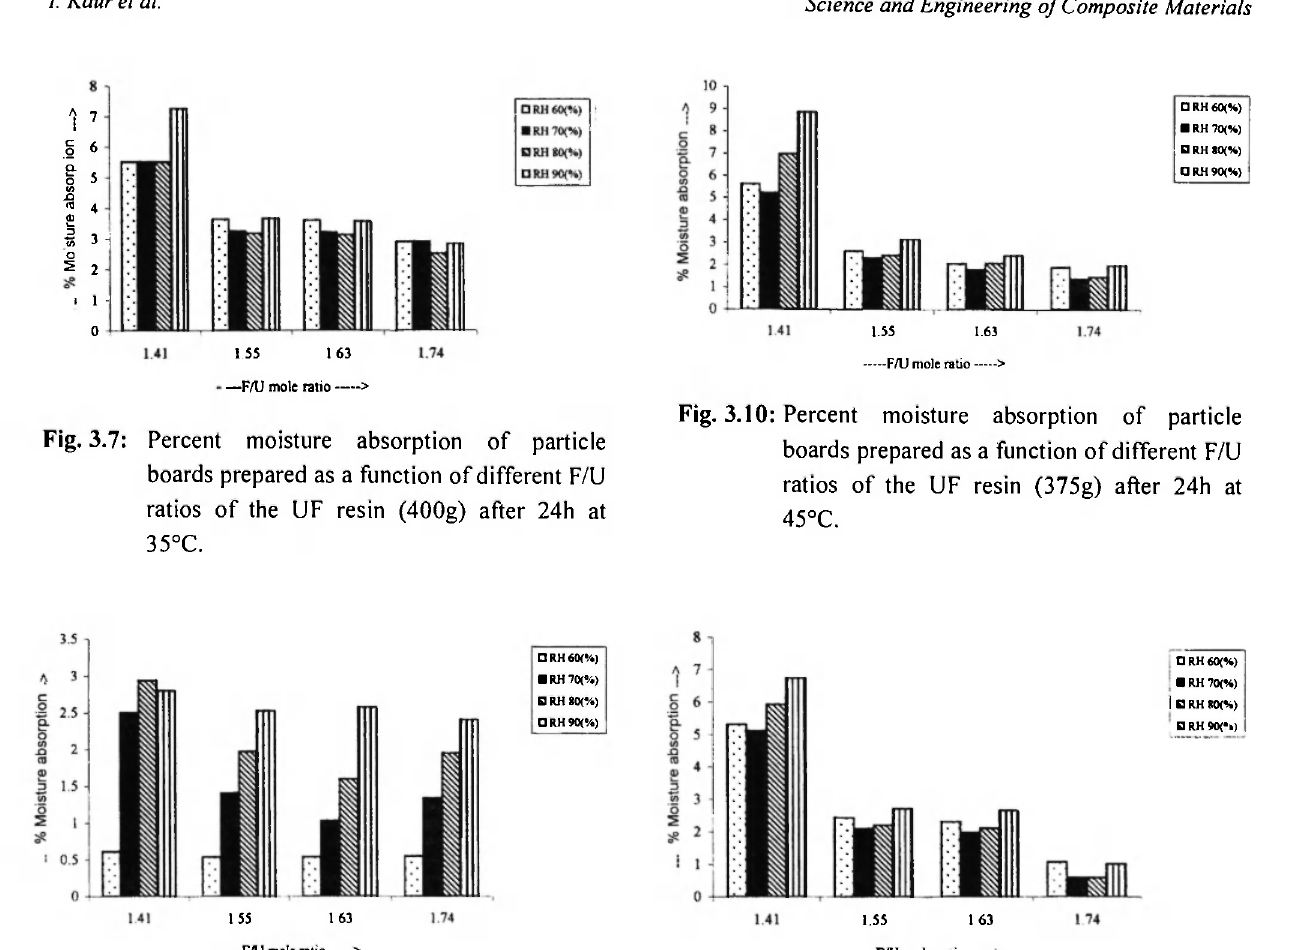
Fig. 3.8: Percent moisture absorption of particle boards prepared as a function of different F/U ratios of the UF resin (425g) after 24h at 35°C.